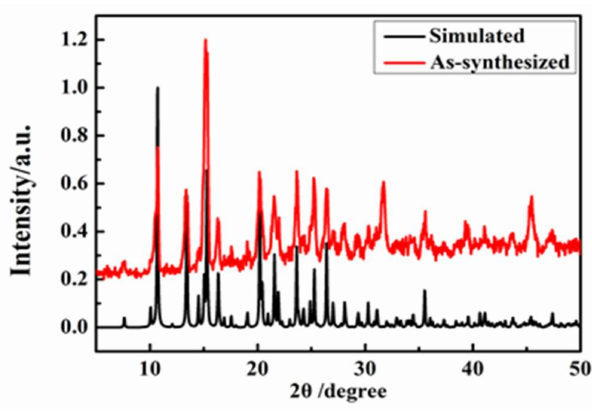
Figure 10. The PXRD spectrum of Complex 2